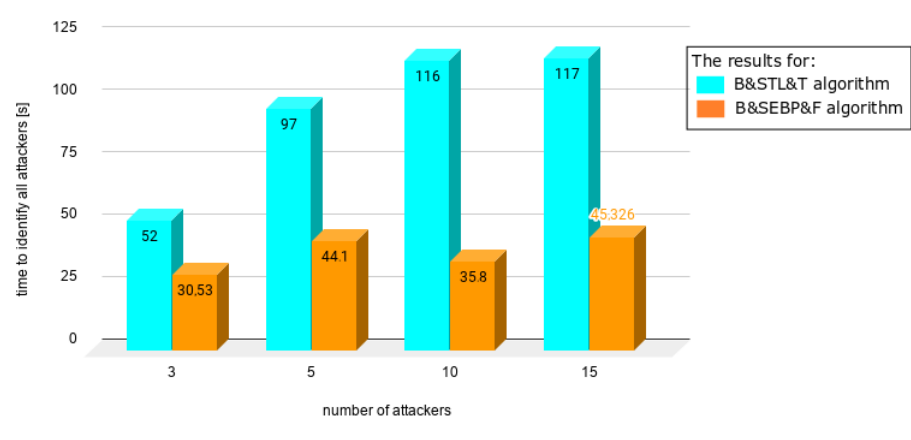
Figure 14. Results from experiments no. 16, 17, 18, and 19 (experiments can be found in Tables 3–7); the graph presents the situation when there are equal numbers of regular users and